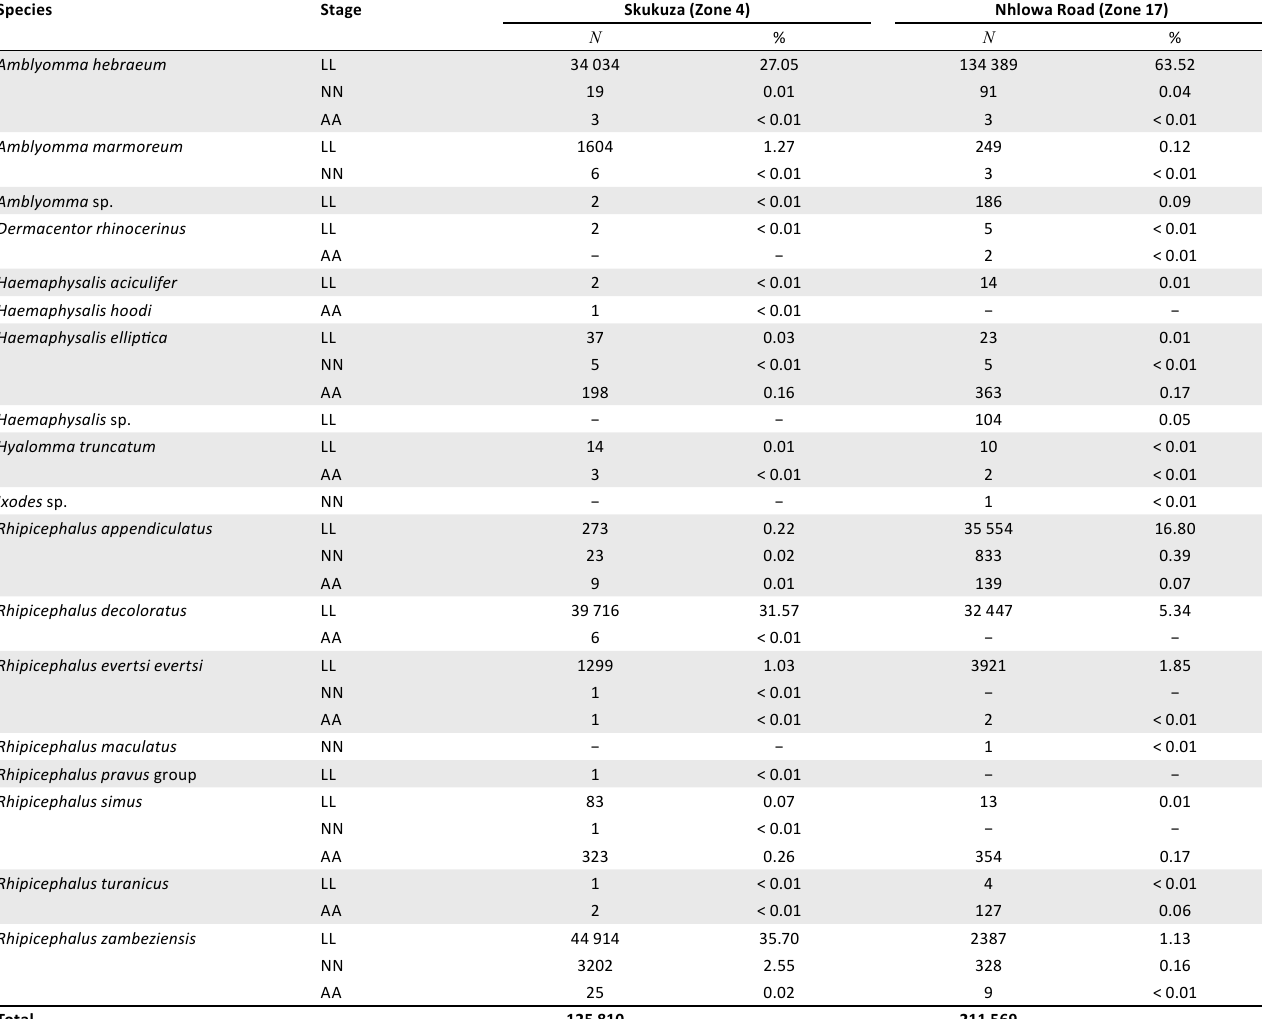
TABLE 1: Number of ticks collected by dragging at the Skukuza and Nhlowa Road sites in the Kruger National Park from August 1988 to March 2002, organised according to species and life stage.